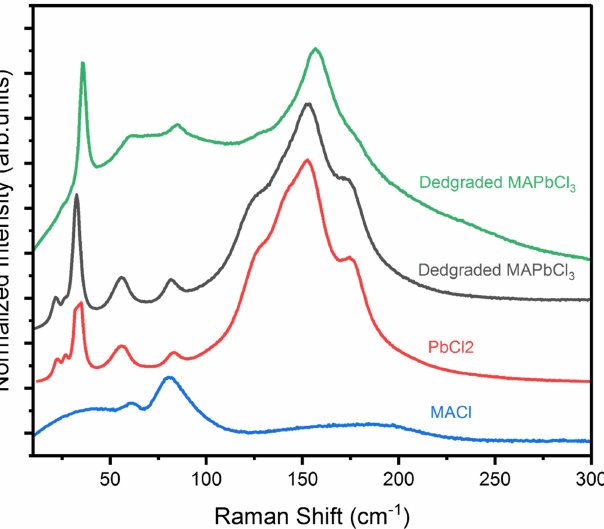
Figure 9. (Color online) Raman spectra of degraded MAPbCl 3 compared with that of its byproducts (PbCl 2 and MACl) at room temperature. The black, solid line indicates the crystal degraded due to exposure to high temperature and the green, solid line indicates the one exposed at ambient condi ‐ tion for a prolonged time. The Raman spectra of PbCl 2 and MACl are also shown for comparison. To check the effect of time evolution on the structural change of MAPbCl 3 and com ‐ pare it with the temperature evolution described above, we kept the sample in the ambient condition for one month and then measured its Raman spectrum. The Raman spectrum, which is shown as a green, solid line in Figure 9, was different from the original spectrum of the pristine MAPbCl 3 and was similar to that of the sample degraded by high tempera ‐ tures. It would thus be interesting to compare the Raman spectra of possible byproducts and the degraded/decomposed MAPbCl 3 . Principally, MAPbCl 3 should decompose into its two expected byproducts, namely PbCl 2 and MACl. To check this, we compared the